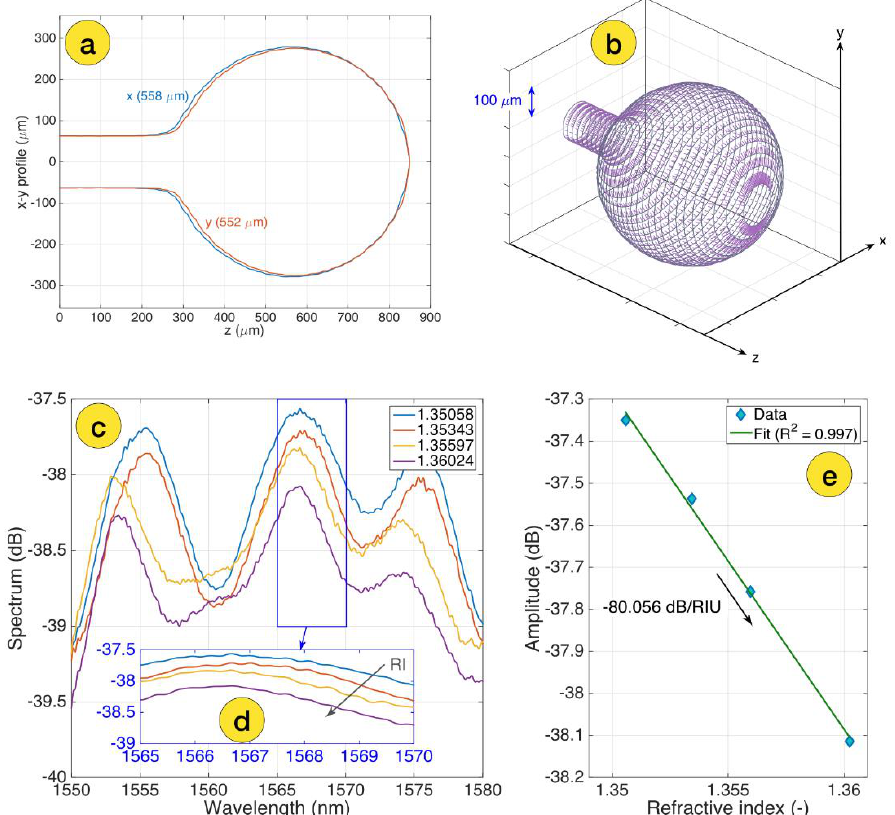
Figure 2. Design and calibration of the ball resonator biosensor: ( a ) two-sided profilometry of the ball resonator, measured through the CO 2 laser splicer; ( b ) 3D mesh of the ball resonator, highlighting the longitudinal cross-sections (grey) and azimuthal planes (purple); ( c ) S-polarization spectrum of the bare ball resonator sensor, measured for different RI values ranging from 1.351 to 1.360; ( d ) the inset shows the spectral feature around 1567 nm used for spectral tracking of the intensity; ( e ) RI calibration, showing the change of intensity as a function of the RI change and sensitivity estimation (-80.056 dB/RIU).